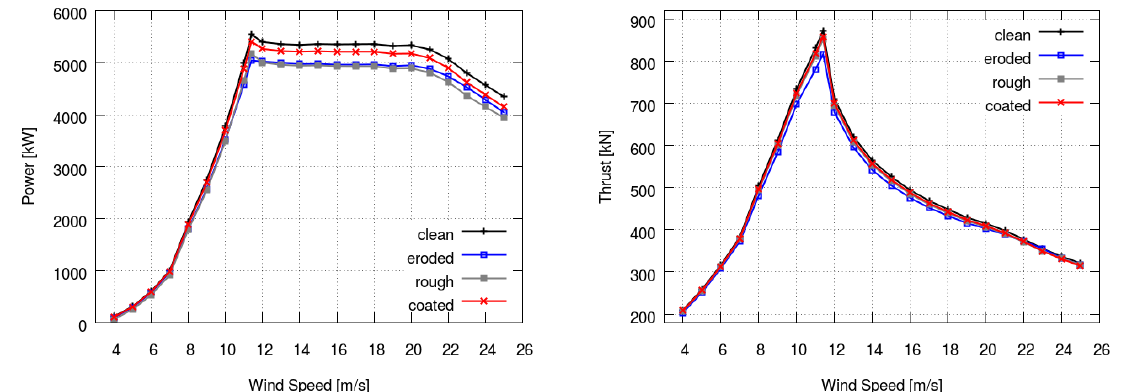
Figure 10. Power and thrust curve of the NREL 5 MW turbine using different sets of polars for the NACA 64-618 airfoil.